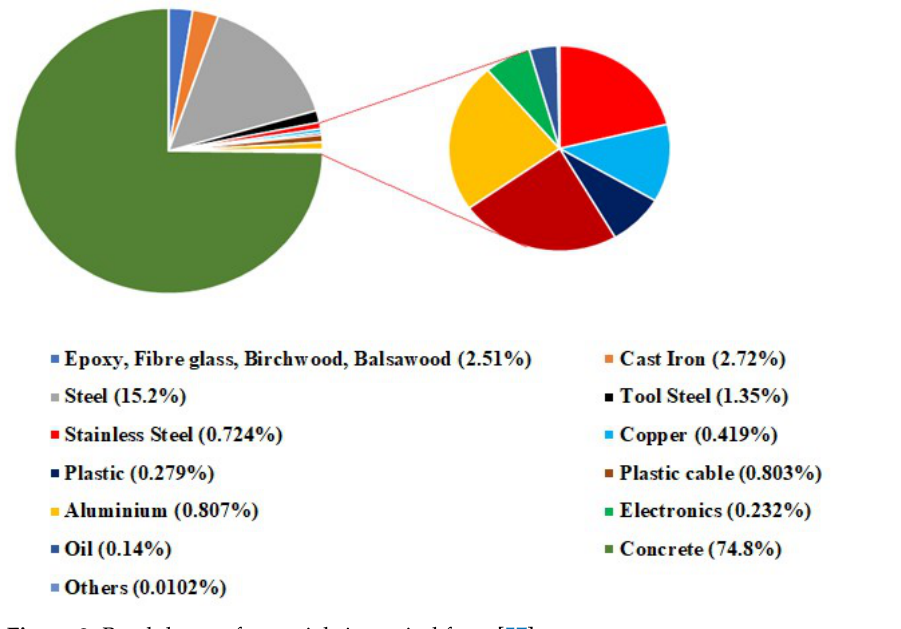
Figure 2. Breakdown of materials in a wind farm